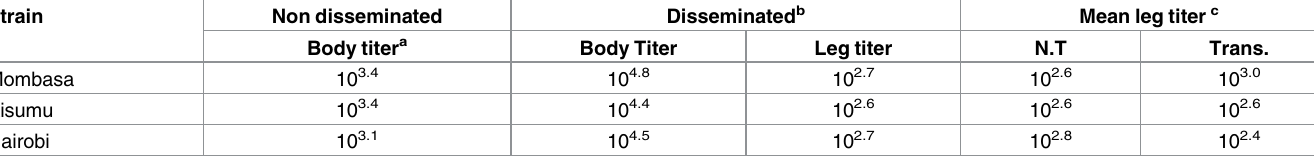
Table 5. Mean body and leg titers for Aedes aegypti from three major cities in Kenya exposed to chikungunya virus.